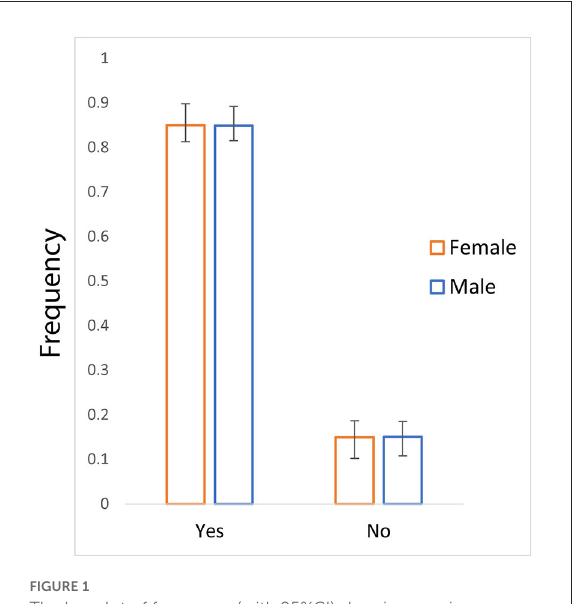
FIGURE1 The bar plot of frequency (with 95%CI) showing vaccine hesitancy for male and female participants.